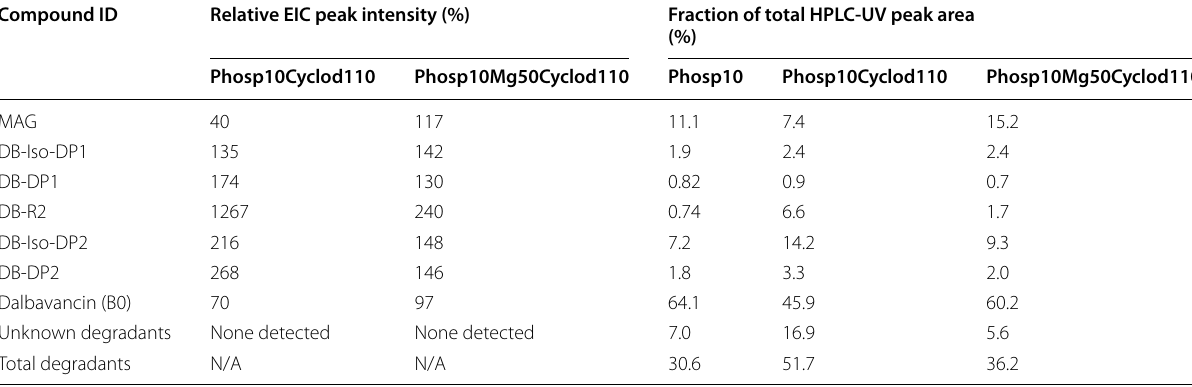
Table 6 The effect of 2HPβCD with and without Mg 2 + on the yields of degradation products of dalbavancin found after stressing at 70 °C for 3 days in 10 mM phosphate